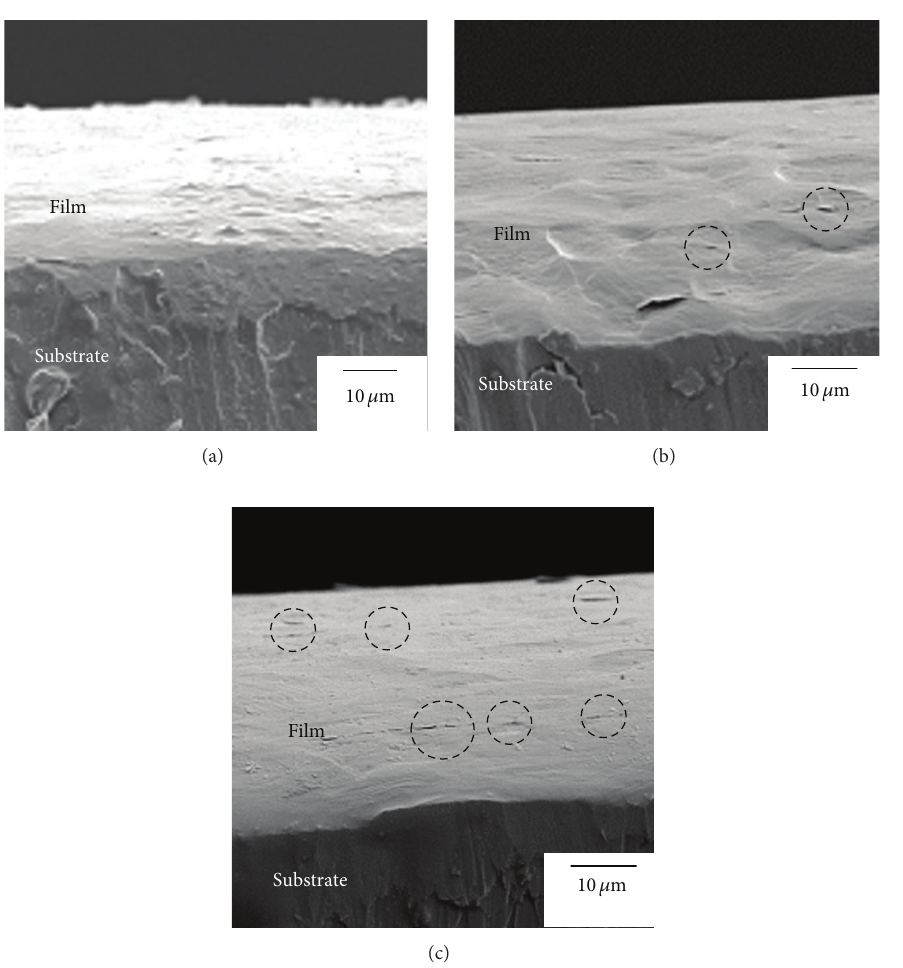
Figure 7: Cross-sectional SEM images of films deposited at various bias voltages (0.5, 2.0, and 5 V), with bias frequency of 1kHz and the Y 2 O 3 concentration of 0.5 wt% in a suspension